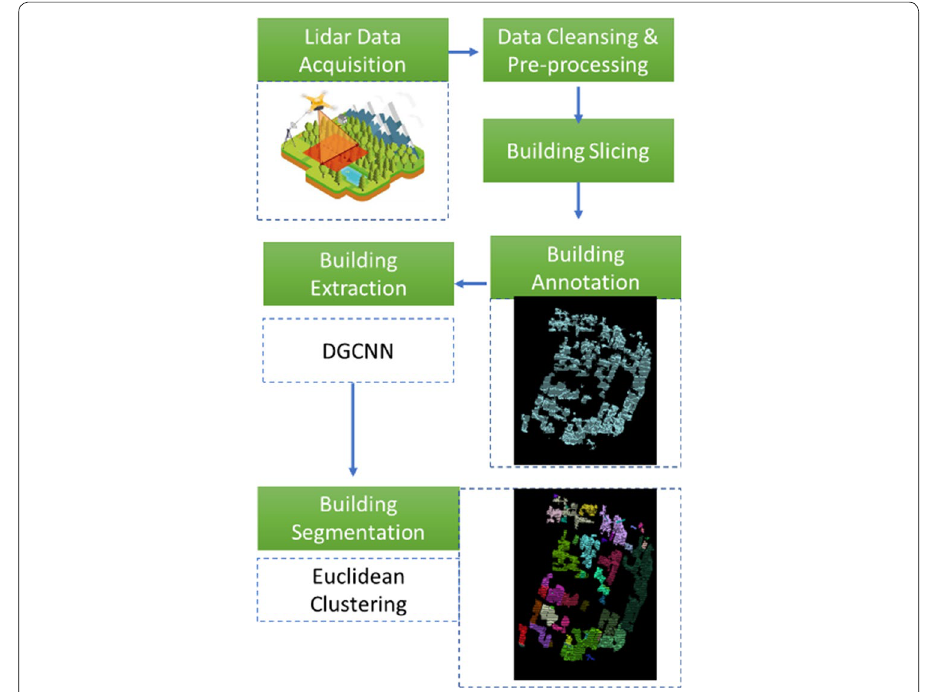
Fig. 2 Automatic building segmentation research